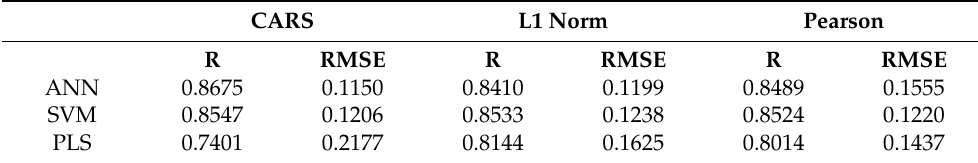
Table 4. Comparison of different models for predictive modeling of apple bruise